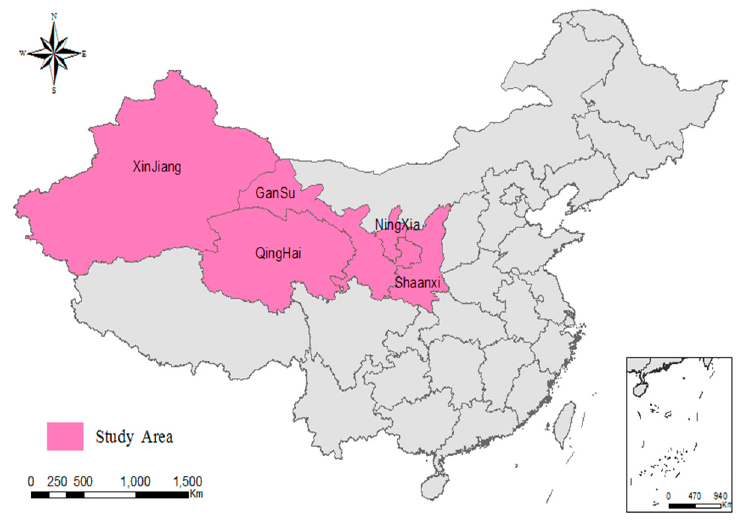
Figure 1 . Northwest China. Figure 1. Northwest